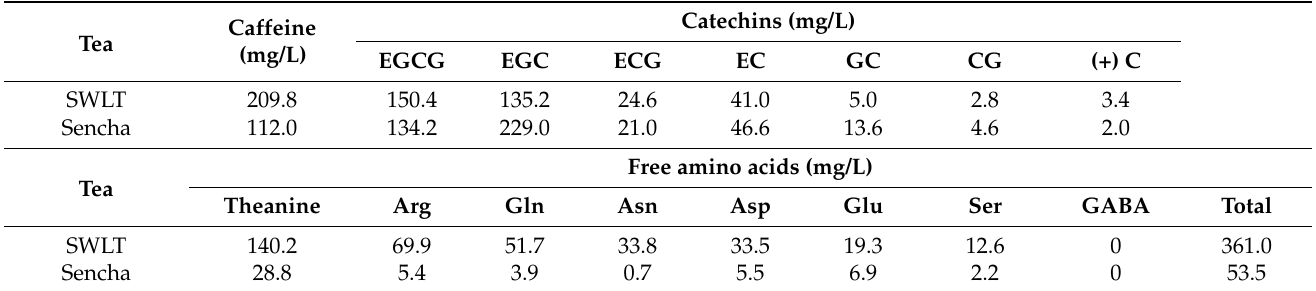
Table 3. The caffeine, catechin, and amino acid contents in the eluate of SWLT and